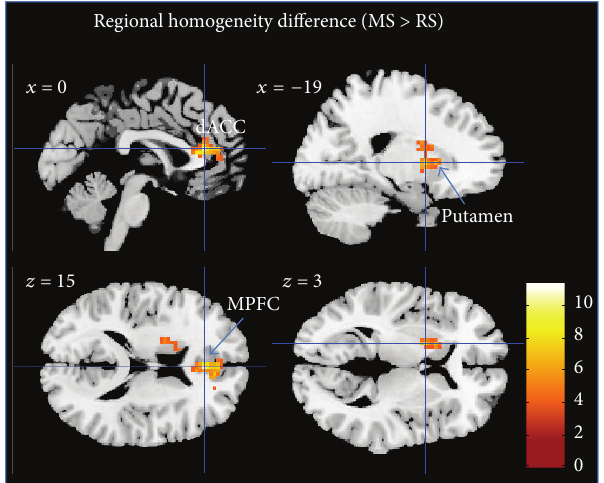
Figure 6: Regional homogeneity difference between MS and RS ( 𝑝 < 0.05 , FWE-corrected). Bar plot represents the 𝑡 -values. White labels indicate the coordinate of each slice in the MNI frame of reference ( 𝑥, 𝑧